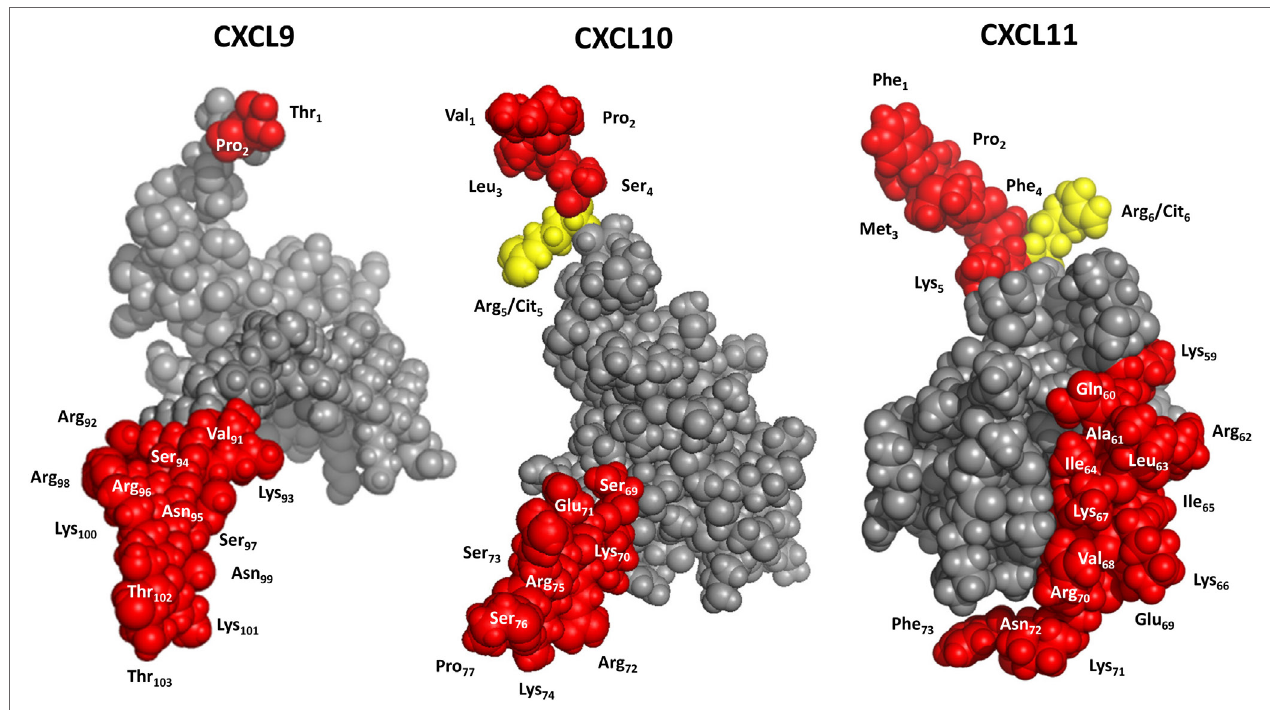
FiGuRe 5 | 3D models of interferon-inducible CXC chemokine receptor 3 (CXCR3) ligands. CXCL9 was modeled with Swiss-Model software using CXCL8 as a template. CXCL10 and CXCL11 were drafted with PDB accession numbers 1LV9 (84) and 1RJT (85), respectively. Yellow, potential citrullination sites; red, residues that can be cleaved off by enzymatic